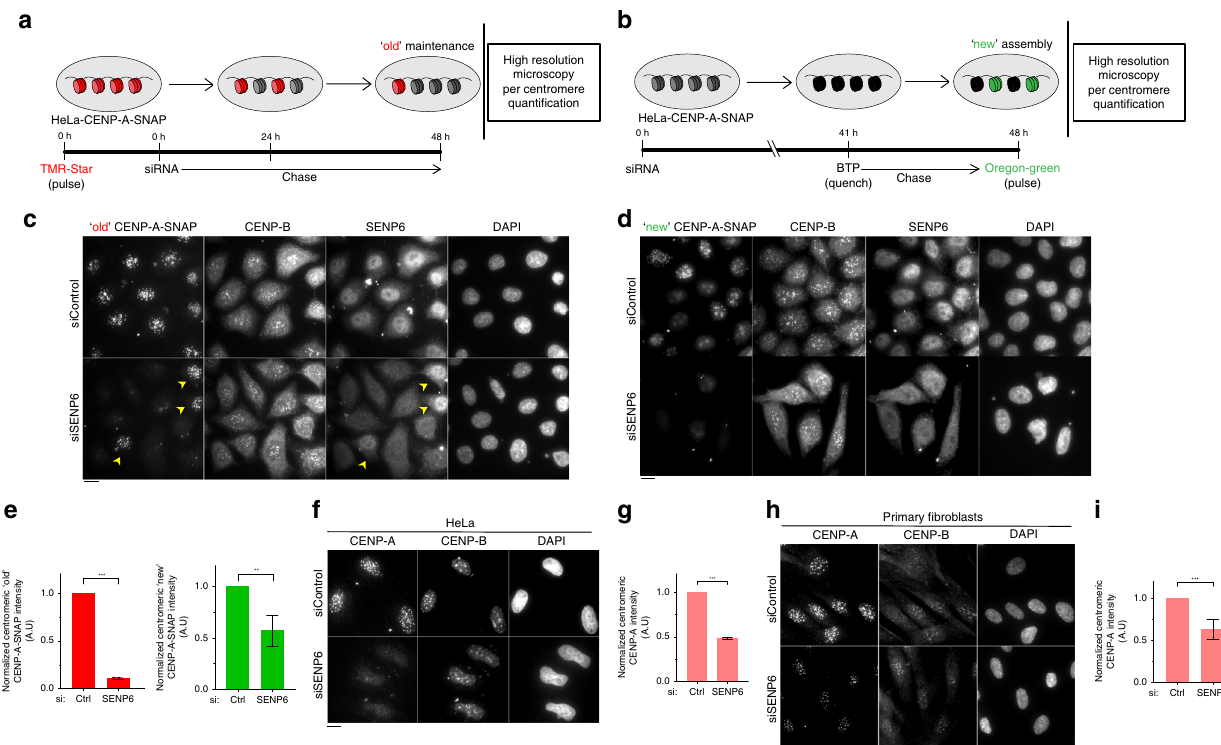
Fig. 2 SENP6, a SUMO protease, controls maintenance of centromeric CENP-A. a , b Schematics for high resolution SNAP pulse-chase ( a ) and quench- chase-pulse ( b ) assays. HeLa-CENP-A-SNAP cells were treated with SENP6 siRNA or a control scrambled siRNA. Pulse-chase experiment was performed for 48 h during RNAi to assay for CENP-A turnover ( a ). Quench-chase-pulse experiment was performed for the fi nal 7 h of siRNA treatment to assay for CENP-A assembly ( b ). c , d shows typical image fi elds following the strategies in a , b , respectively. TMR-Star and Oregon Green SNAP labels visualize the maintenance or assembly of CENP-A-SNAP, respectively. CENP-B was used as a centromeric reference for quanti fi cation. Cells were counterstained for SENP6 to visualize its depletion in siRNA treated cells. Yellow arrowheads indicate nuclei that escaped SENP6 depletion which correlate with retention of ‘ old ’ CENP-A-SNAP. Bars, 10 µ m. e Automated centromere recognition and quanti fi cation of c , d . Centromeric CENP-A-SNAP signal intensities were normalized to the control siRNA treated condition in each experiment. siRNA treatment; siSENP6 or scrambled (Ctrl). Three replicate experiments were performed. Bars indicate SEM. Parametric two-tailed Student ’ s t test were performed to calculate statistical signi fi cance. ** p < 0.01, *** p < 0.001. f Centromeric levels of total, steady state CENP-A under siRNA mediated depletion of SENP6 in untagged HeLa cells. g Quanti fi cation of f as in c , d . h Centromeric levels of total, steady state CENP-A under siRNA mediated depletion of SENP6 in primary fi broblasts. i Quanti fi cation of h as in c and d . Source data are provided as a Source Data fi